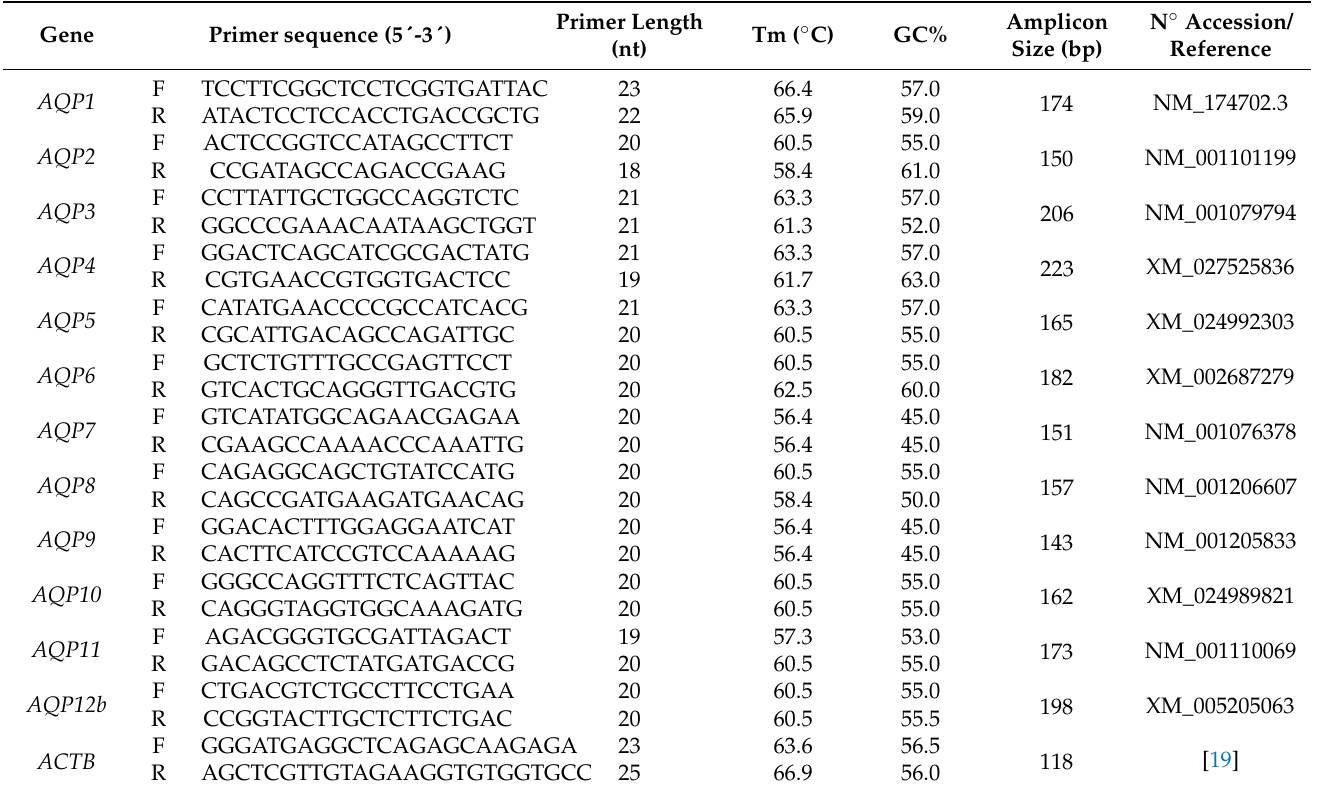
Table 1. Primer sequences for aquaporin ( AQP ) genes in